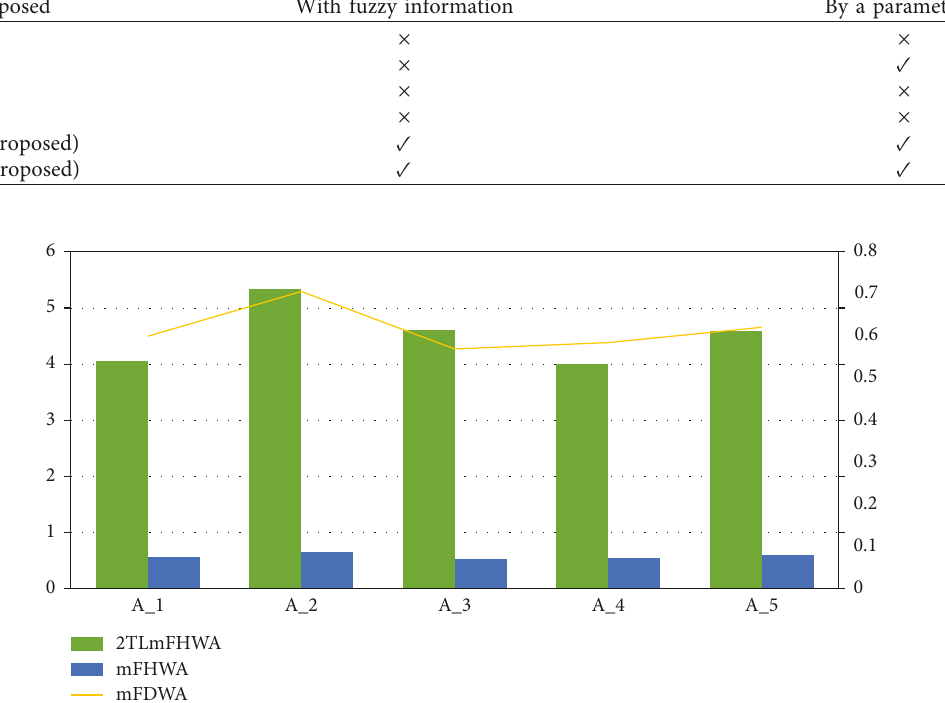
Figure 6: Comparison of proposed operator 2TLmFHWA with existing operators.